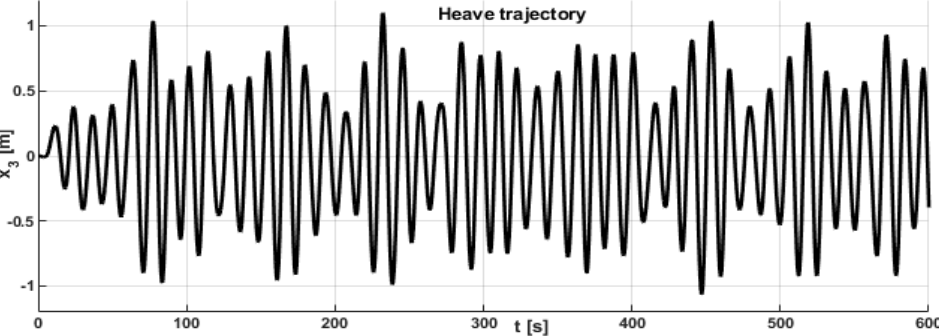
Figure 15. Heave response to IW8 according to weakly nonlinear time − domain solver.